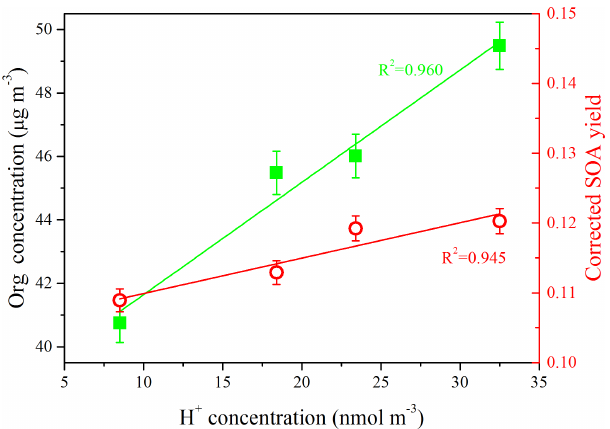
Figure 5. Signal of fitted peaks, i.e., CSO + , CH 3 SO + (right y axis), and sulfur-containing organics concentration (left y axis), as a function of SO 2 initial